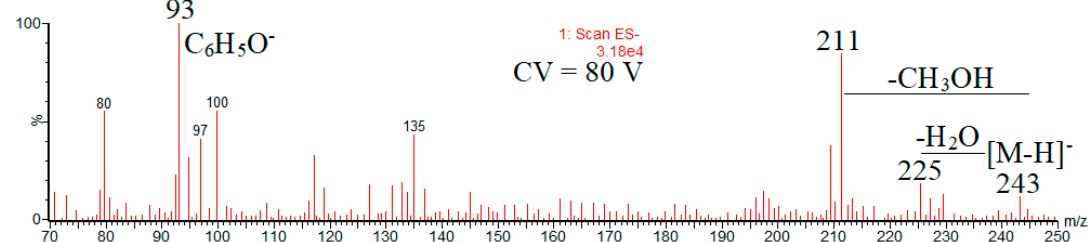
Figure 4. Electrospray ionization mass spectrum of Product 1 obtained at high cone voltage (we have checked if the fragment ions have identical retention time as [M-H] − , otherwise we deal with background ions).